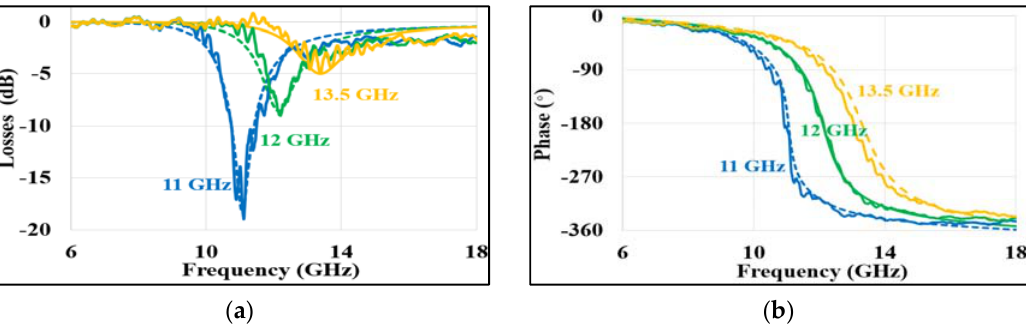
Figure 11. Unit cell reflection measurement and simulation results in continuous lines and dashed lines, respectively: ( a ) reflection magnitude and ( b ) reflection phase.